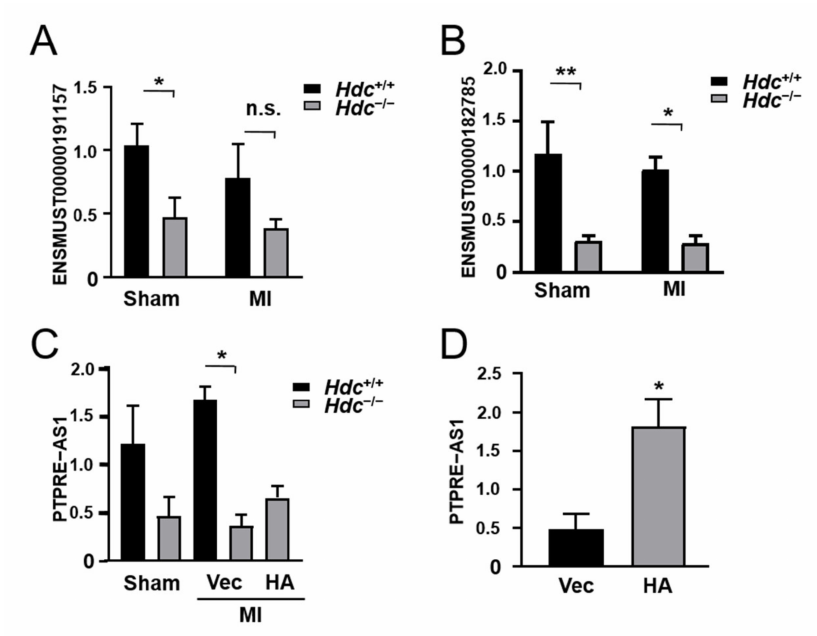
Figure 7. Verification of immune-related lncRNA levels by qRT-PCR. ( A – C ) qPCR results of immune- related lncRNA expression in Hdc +/+ and Hdc − / − mice post MI operation. ( D ) The expression of PTPRE-AS1 in RAW264.7 cells with histamine treatment. n = 3–5, * p < 0.05, ** p < 0.01, n.s. no